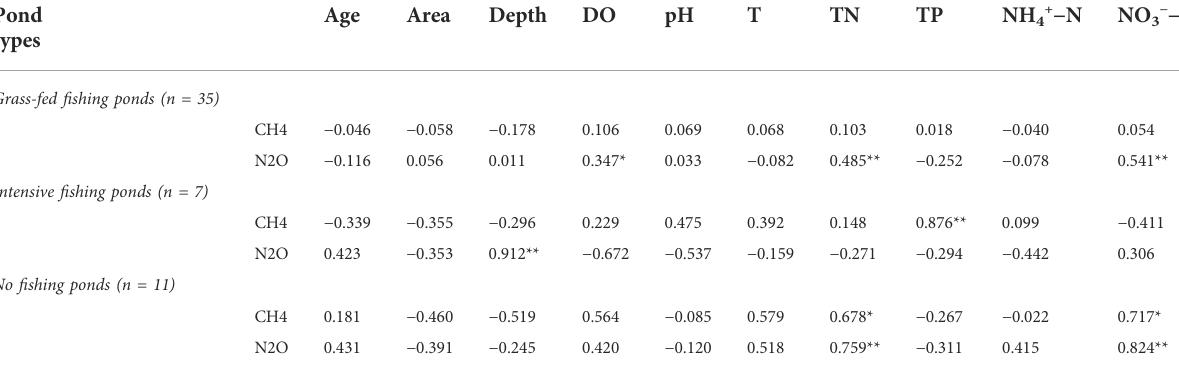
TABLE 3 Pearson ’ s correlation coef fi cients between CH 4 and N 2 O emission fl uxes and environmental variables in different management types of ponds. Pond types